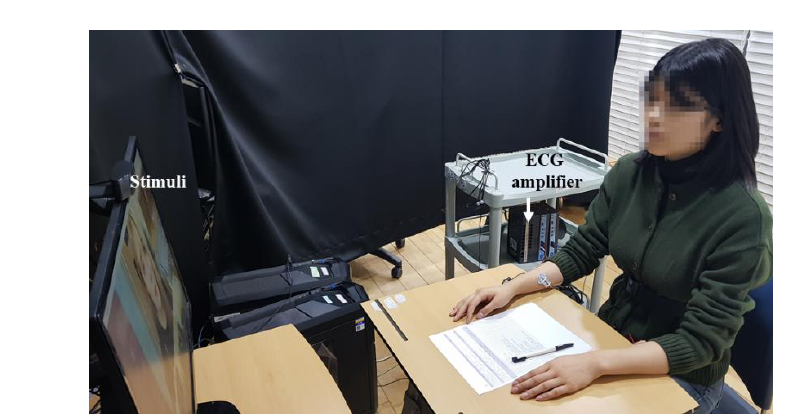
Figure 2. Flow chart of the experiment.